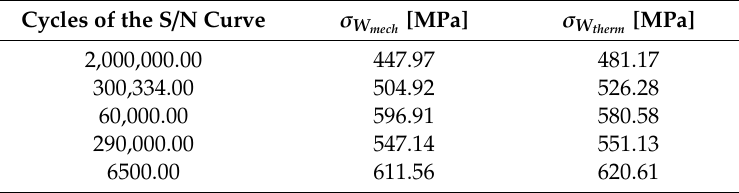
Table 4. Stress obtained by using W mech , W therm as input for the Equation (9). Cycles of the S / N Curve